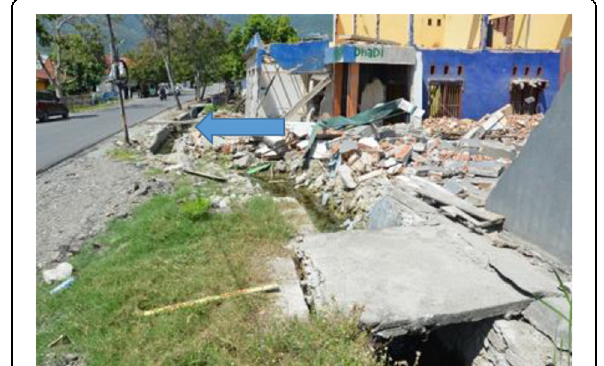
Fig. 6 Large ground displacement of 4.5m at Kedondong street in